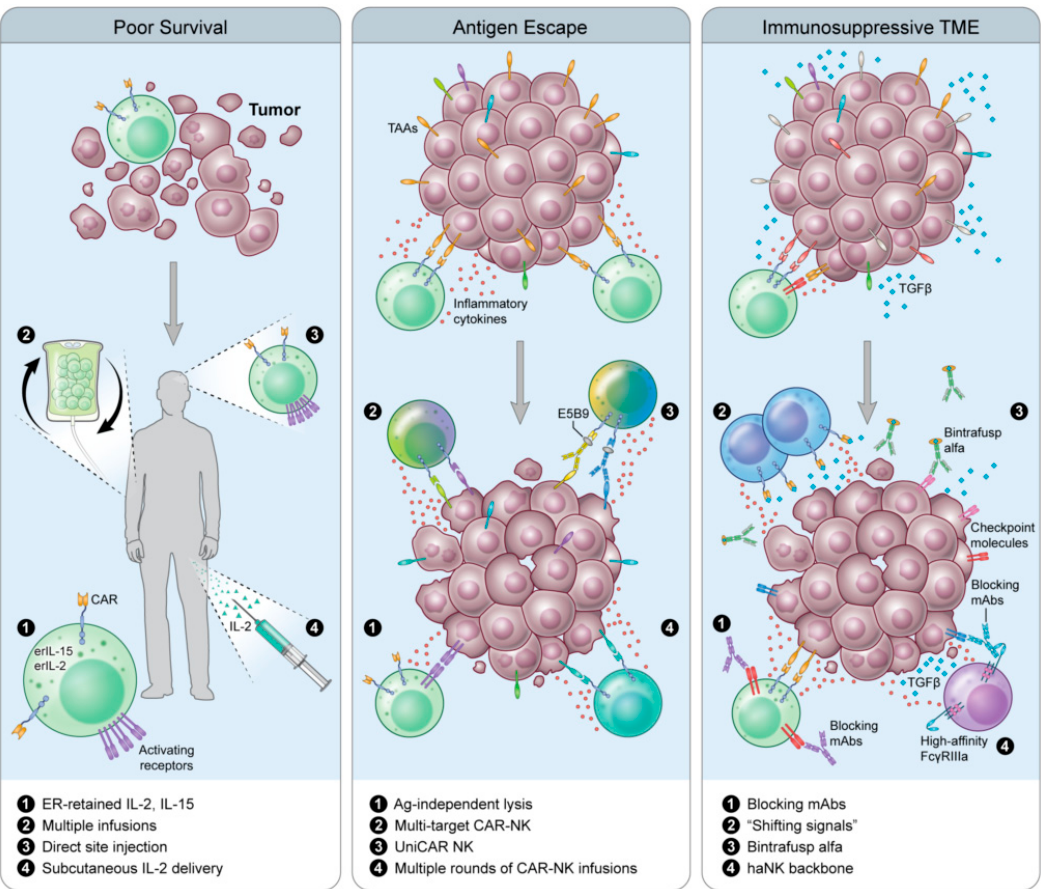
Figure 2. Overcoming CAR-T resistance with genetically modified NK cells. ( A ) Poor survival of adoptively transferred cells can be overcome in a variety of ways such as ER-retained cytokines, multiple infusions of CAR NKs, direct site injection and subcutaneous delivery of IL-2 to promote in vivo survival. ( B ) Antigen escape can be overcome by NK cells’ ability to lyse target cells in an antigen-independent manner, generation of multi-target CAR-NKs, universal CAR-NKs directed to multiple tumor antigens simultaneously or in succession, and the ability to infuse multiple rounds of CAR-NK cells. ( C ) The immunosuppressive TME is a challenge for CAR-T and CAR-NK cell therapy. Some strategies to overcome this include combining CAR-NK with blocking mAbs, using CAR-NKs with receptors specific for inhibitory cytokines that signal through an activating receptor domain, sequestering of inhibitory cytokines through combinatorial use of bintrafusp alfa (a bifunctional protein targeting TGF β and PD-L1), and having CAR-NK cells that express the high affinity Fc γ RIIIa receptor to increase ADCC potential.